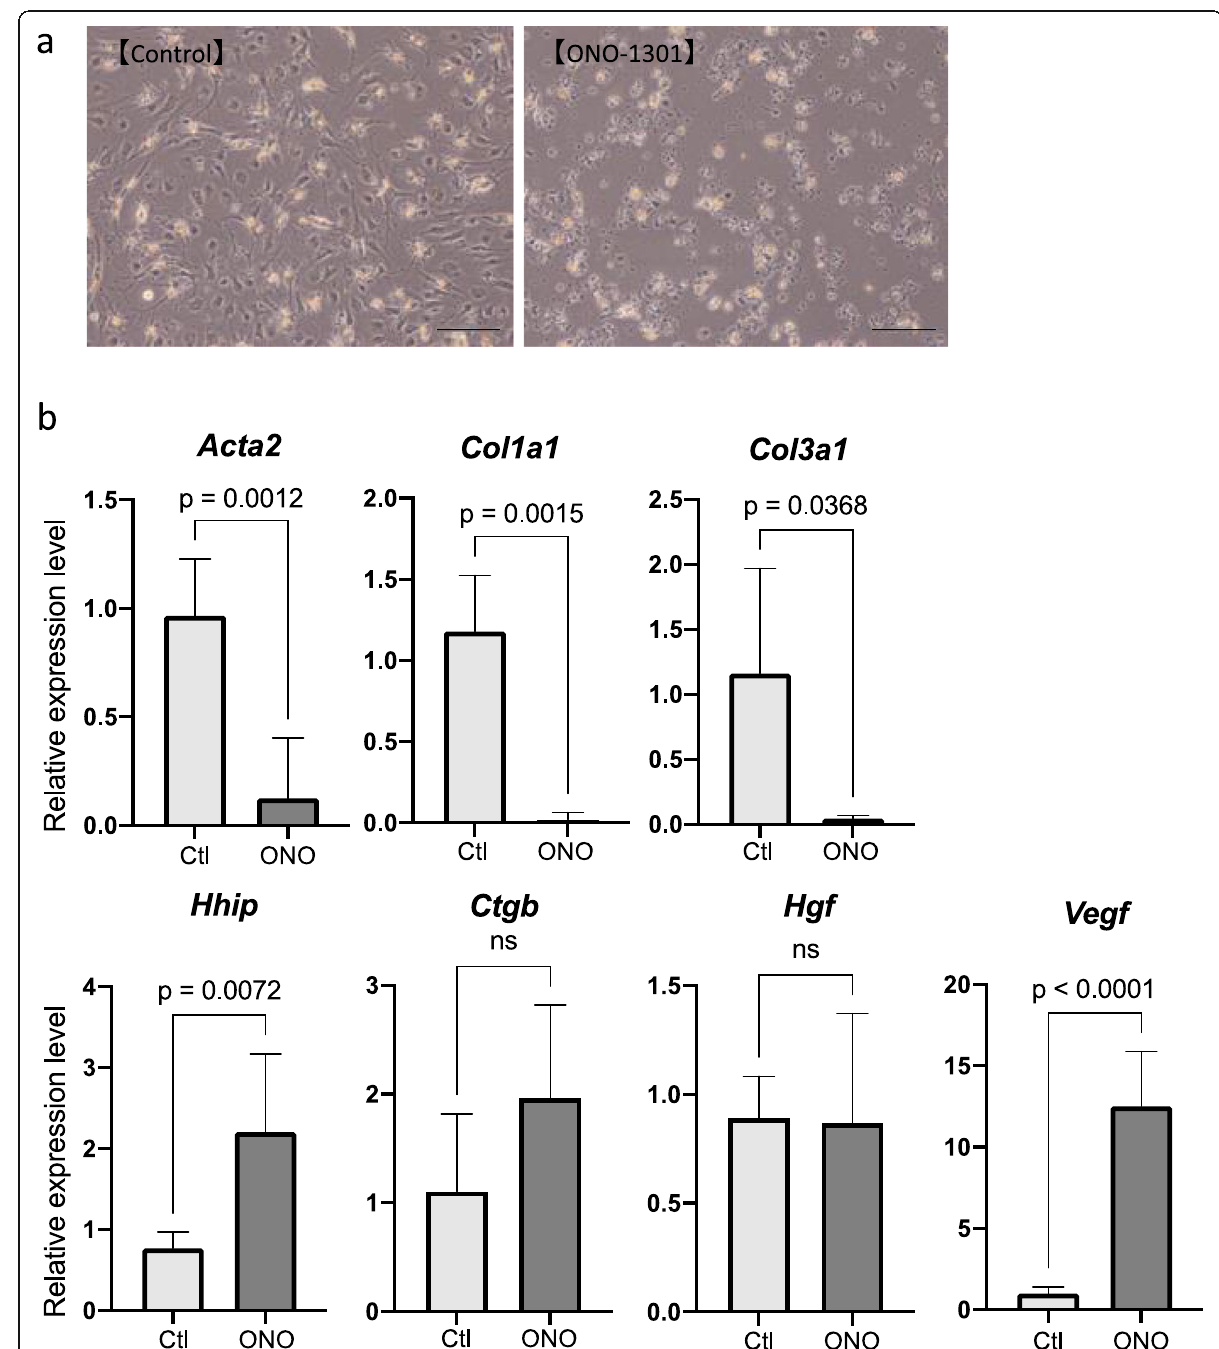
Fig. 5 Effects of ONO-1301 against hepatic stellate cells (HSCs) in vitro. A Macroscopic features of HSCs on day 3 with or without ONO-1301. B After addition of ONO-1301 (0.1 μ M) or vehicle to HSC cultures, mRNA expression levels of Acta2 , Col1a1 , Col3a1 , Hhip , Ctgb , Hgf , and Vegf were analyzed (each experiment was repeated five to seven times). Scale bar = 100 μ m. Data are presented as mean ± standard deviation. ns: not